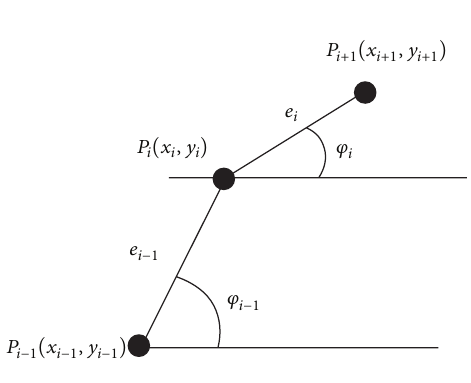
Figure 10: Route and railway symbols.